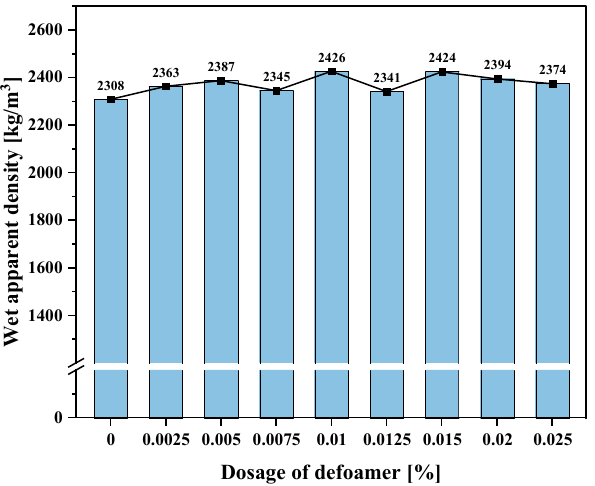
Figure 2. Influence of defoamer on the wet apparent density of grouts.